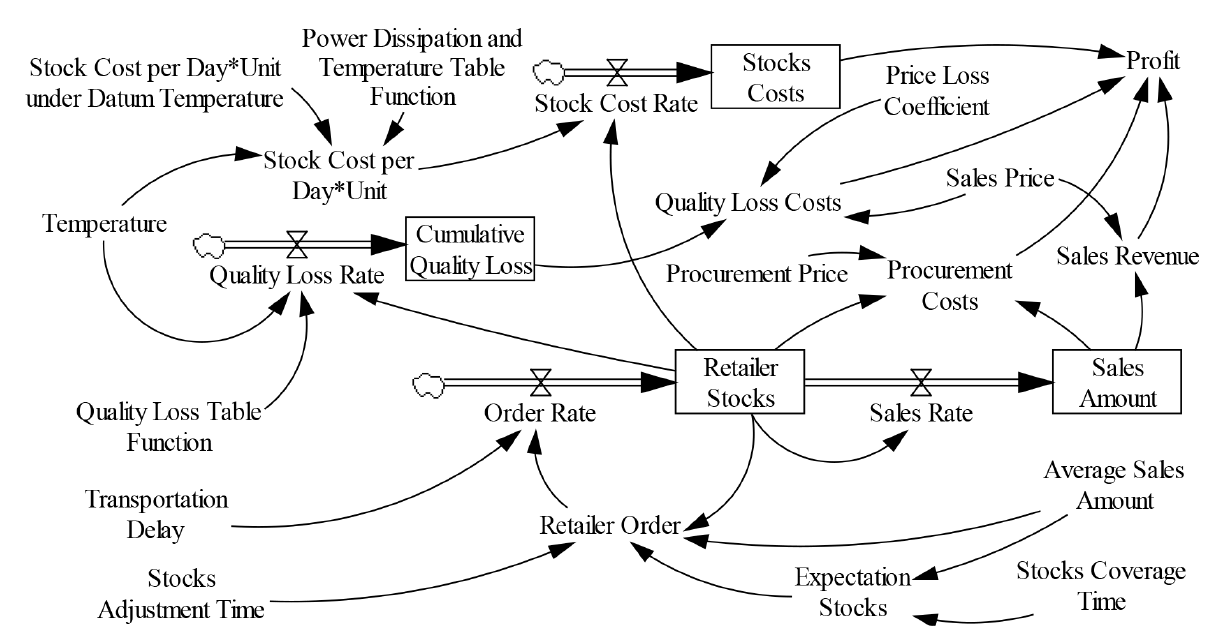
Figure 4. The flow diagram of aquatic product cold-chain